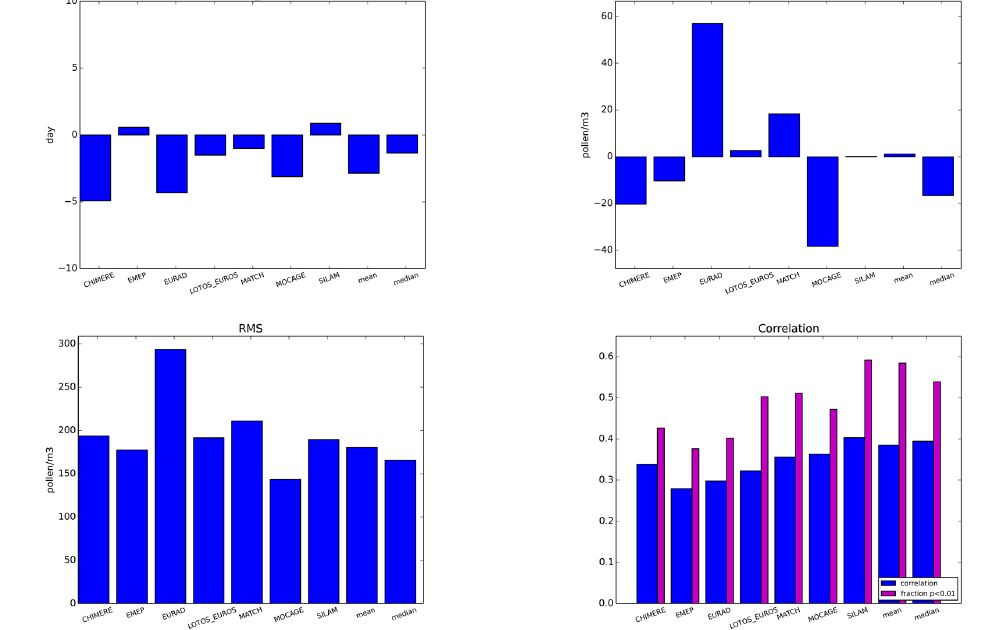
Figure 8. Scores of the individual models: mean over all stations. The parameters are the same as in Fig. 7.